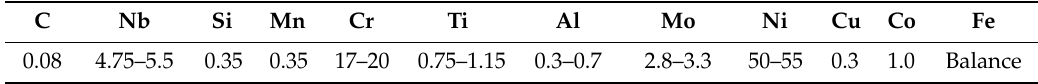
Figure 1. Positioning and clamping of specimens. Table 1. The chemical composition of the GH4169 superalloy (unit: %).